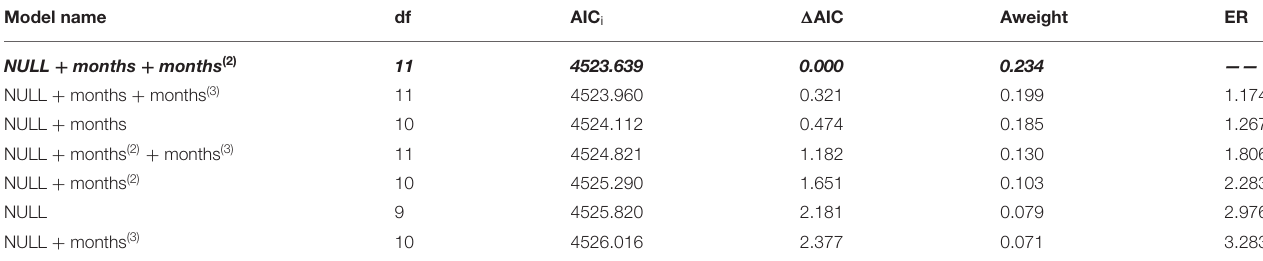
TABLE 3 | Regression models constructed to investigate the time-dependency of fatigue in MS.